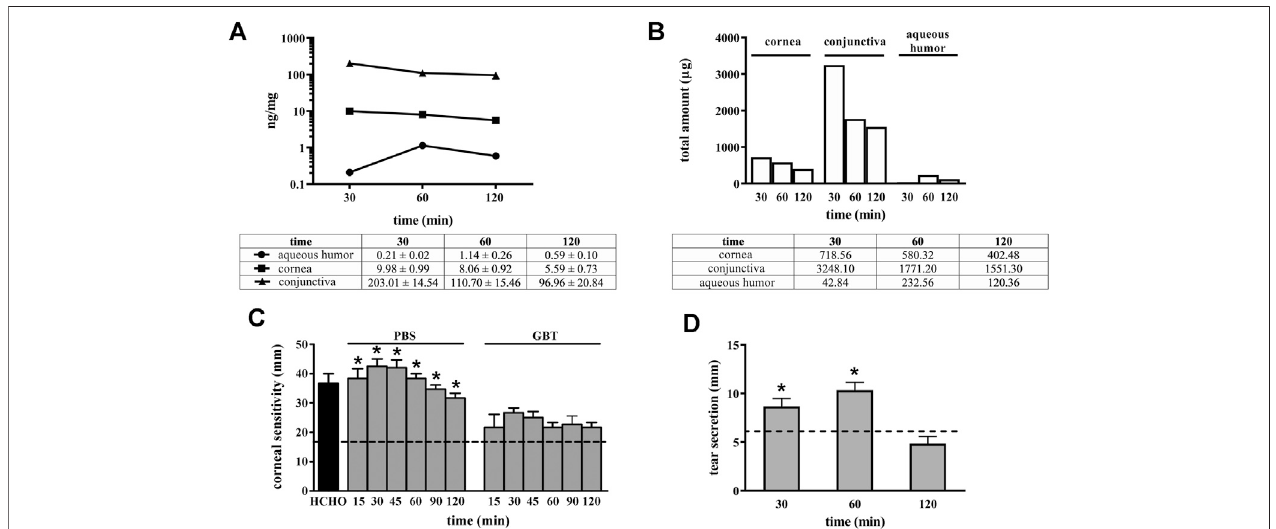
FIGURE 1 | Pharmacokinetic pro fi le of GBT (2% in PBS) in ocular tissues and GBT analgesic effects. GBT was measured in aqueous humor, cornea and conjunctiva at different times. For each tissue, concentration pro fi les derived from four samples per treatment are reported in ng/mg of tissue (A) , or as total estimated amountineach tissue (B) . (C) Effectsof2%GBToncornealpain. Longitudinalevaluation ofcornealsensitivityusingtheCochet-Bonnetesthesiometryinrabbits treated with PBS or GBT after the instillation of 0.5% formaldehyde. The dotted line indicates the basal value. Differences between groups were tested for statistical signi fi canceusingone-wayANOVAwithTukey ’ smultiplecomparisonpost-test( n (cid:2) 6). (D) Effectsof2%GBTinPBSontearsecretion.Thedottedlineindicatesthebasal value.Differences vs. basalsecretion weretested forstatisticalsigni fi cance usingtwo-wayANOVA with Bonferroni multiple comparison post-test. * p < 0.05. Alldata are plotted as mean ± SEM.